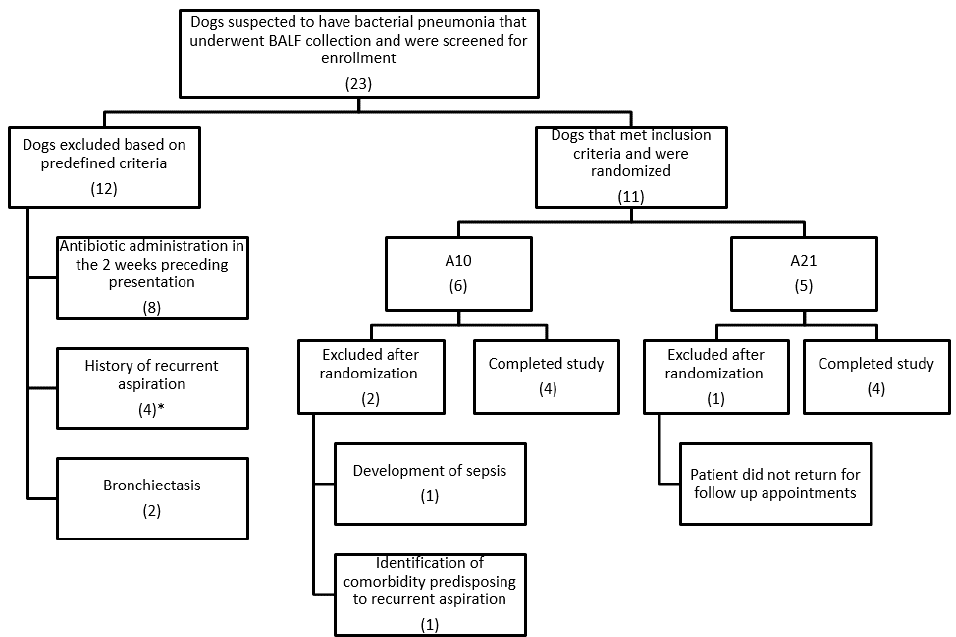
Figure 1. Flow chart indicating patient selection for study enrollment. Numbers in parentheses indicate the number of dogs. A10, patients received 10 days of antibiotics and 11 days of placebo; A21, patients received 21 days of antibiotics; BALF, bronchoalveolar lavage fluid. * Two out of four dogs with historical recurrent aspiration also received antibiotics in the 2 weeks preceding presentation. Table 2. Summary of the clinical signs, diagnostic results and final diagnoses for dogs enrolled in each group.